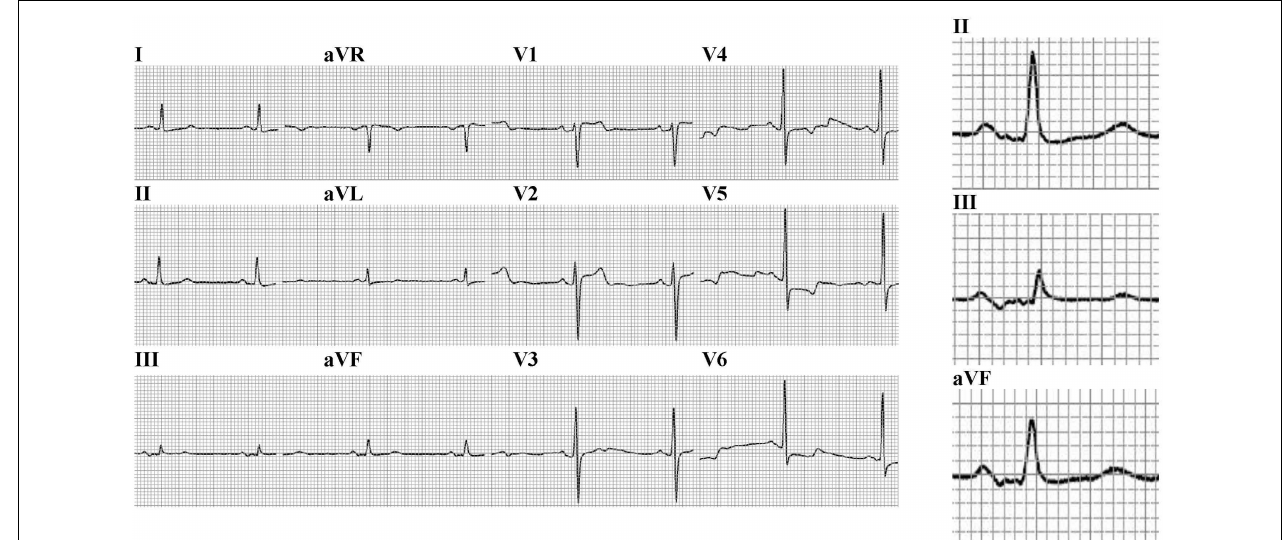
FIGURE 2 | The 12-lead electrocardiogram of a patient with advanced interatrial block (P-wave duration > 120 ms with a biphasic morphology in inferior leads) (25 mm/s, 10